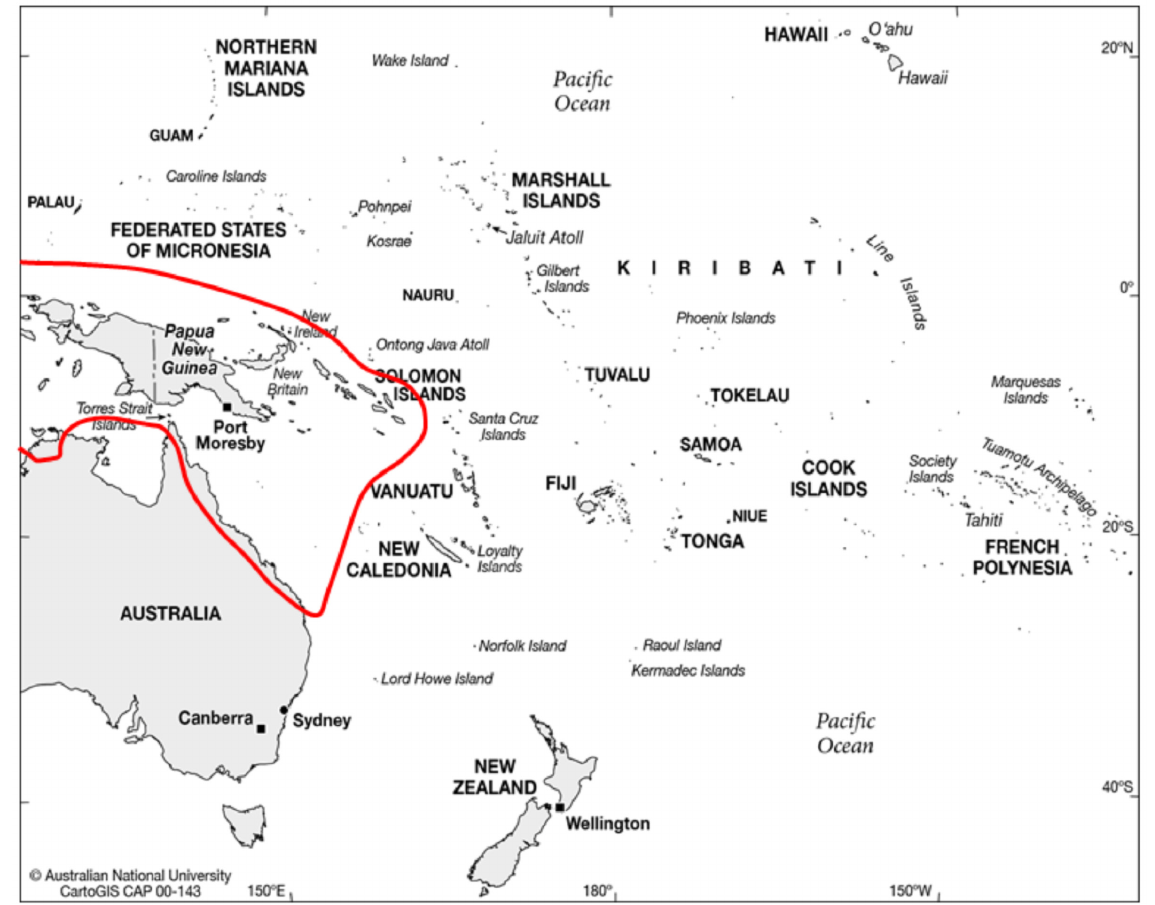
Fig. 18. Regional distribution of the genus Uvaria (Annonaceae) in the Pacific. Base map sourced from CartoGIS, College of Asia and the Pacific, The Australian National University,